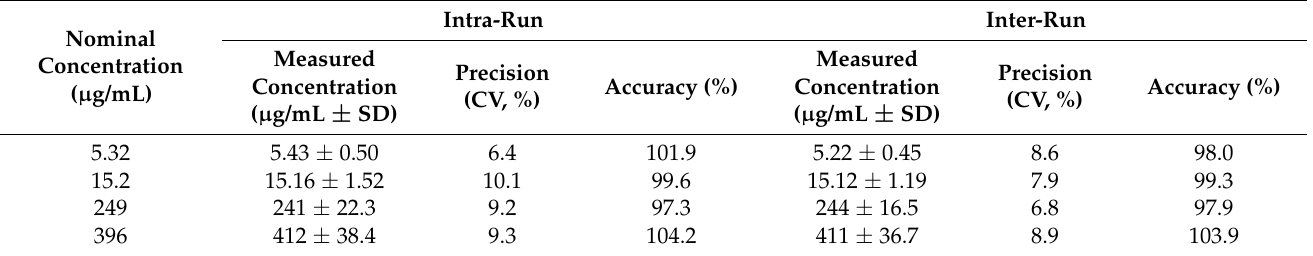
Table 2. Precision and accuracy values at LLOQ, LQC, MQC, and HQC concentration of trastuzumab in human plasma samples during the course of validation ( n =